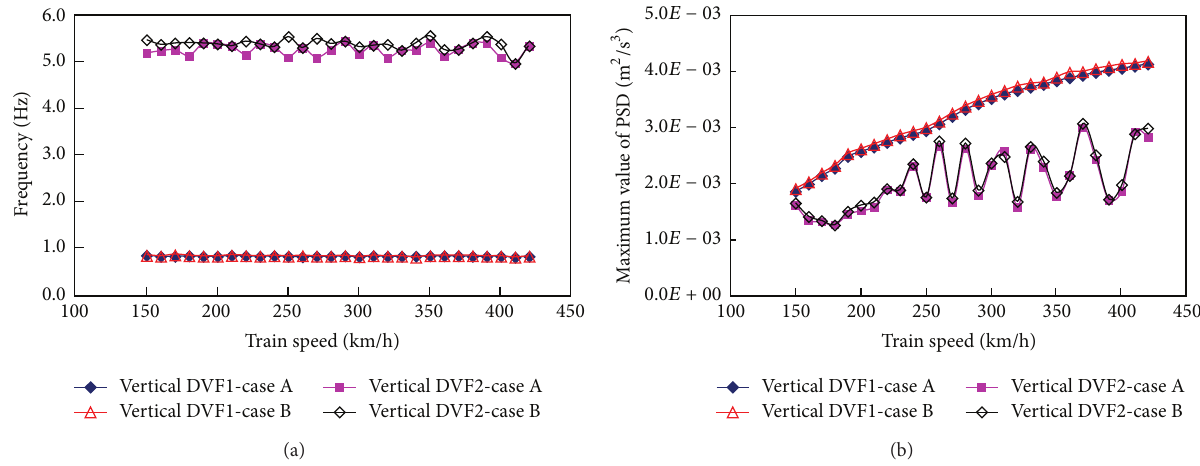
Figure 9: Trailer carbody vertical acceleration with respect to train speed. (a) DVF. (b) Maximum value of PSD.